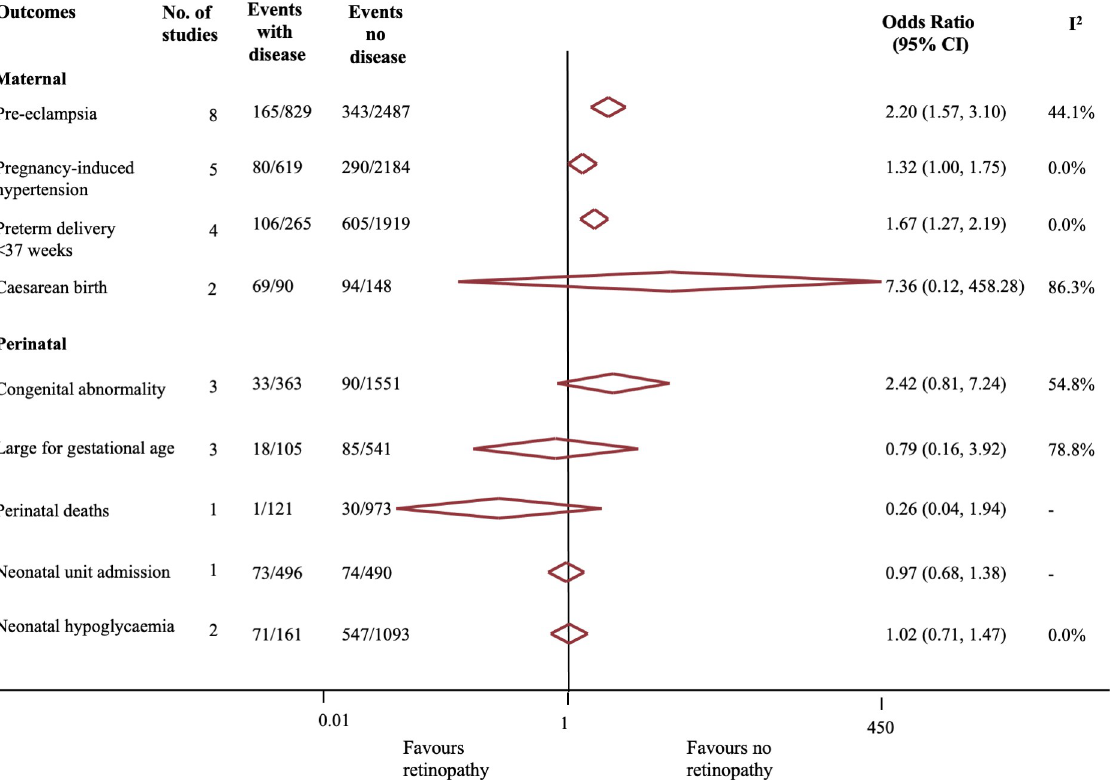
PLOS Medicine| https://doi.org/10.1371/journal.pmed.1003856 November22,